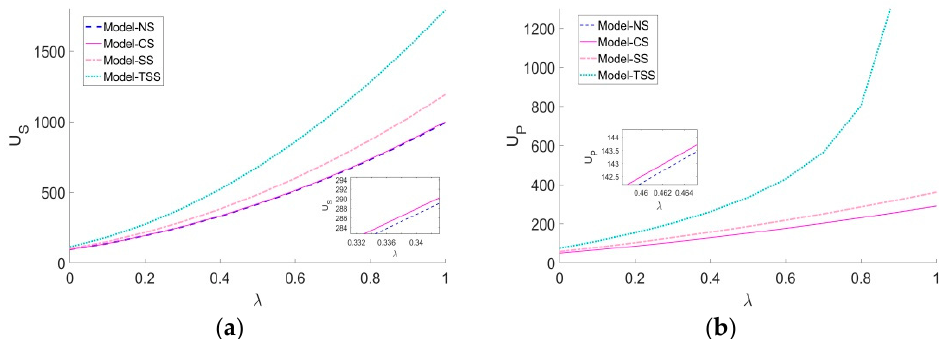
Figure 6. Effect of the proportion of green consumers λ on the utilities of supply chain members. ( a ) Supplier utility. ( b ) Platform utility.